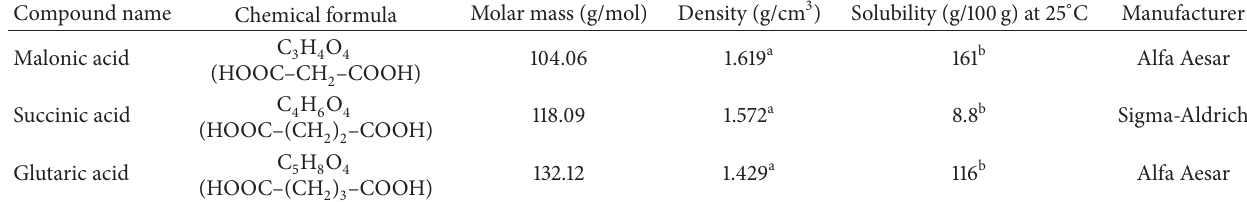
Table 1: Chemical properties of organic compounds.